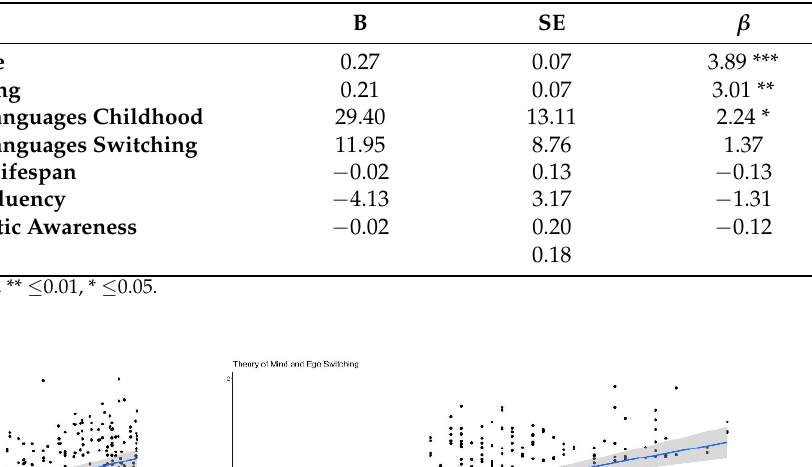
Table 4. Multiple regression analysis of ToM with social network variables as predictors ( N = 89).